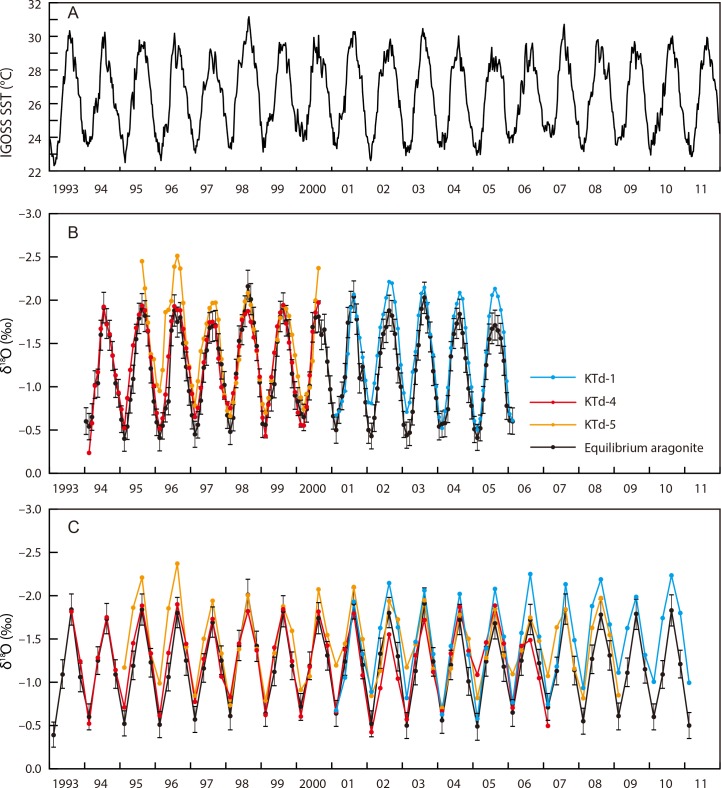
Comparison of time series of sea surface temperature and δ18Oshell values for Tridacna derasa shells.(A) IGOSS SST data around Ishigakiji-jima (1° resolution gridded data, centered at 24°30′N and 124°30′E) during the period 1993–2011. (B) Monthly resolved δ18Oshell profiles of the KTd-1, KTd-4, and KTd-5 shells and equilibrium aragonite. (C) Seasonally resolved δ18Oshell profiles of the KTd-1, KTd-4, and KTd-5 shells and equilibrium aragonite. Each error bars indicates ±1 standard error.